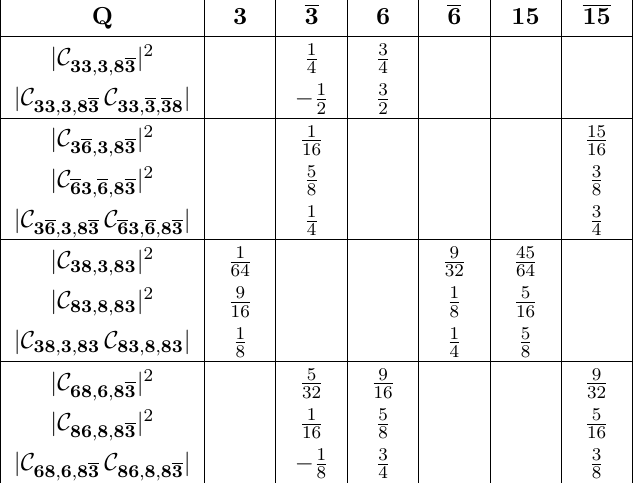
Table 3 . Clebsch-Gordan coe(cid:14)cients (cid:12) Q , described in equation (B.5), corresponding to the di(cid:11)erent possible SU (3) eigenstates of the initial states for s -channel X annihilation (the three leftmost diagrams of (cid:12)gure